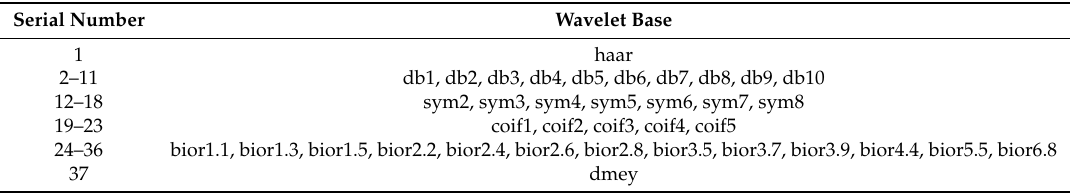
Figure 3. Signal to noise ratio (SNR) and root mean square error (RMSE) of noise reduction for the different wavelet bases.